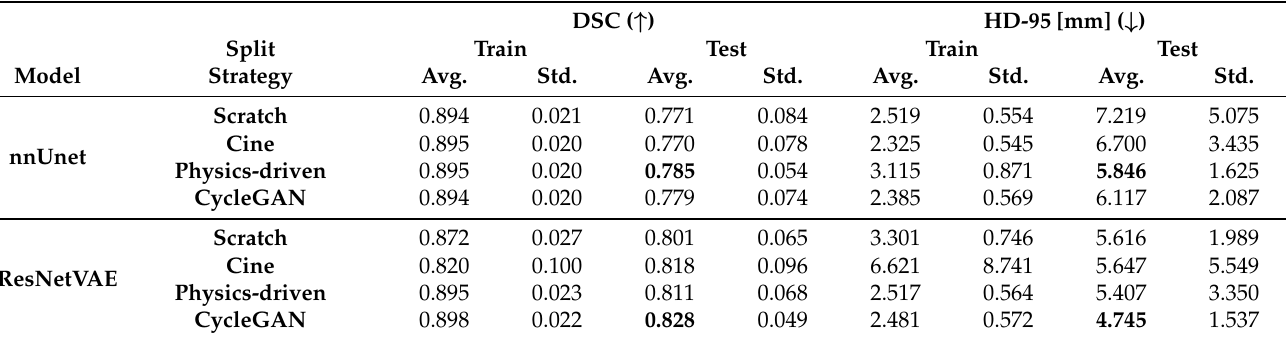
Table 3. Performance metrics for the evaluated architectures, training strategies, and data splits. Displayed are the Dice coefficient (DSC) and 95th percentile Hausdorff Distance (HD-95) for which higher and lower are better, respectively. The average (Avg.) and standard deviation (Std.) statistics are computed over the training and testing data splits containing 1000 and 250 2D SAX tagged MR images,